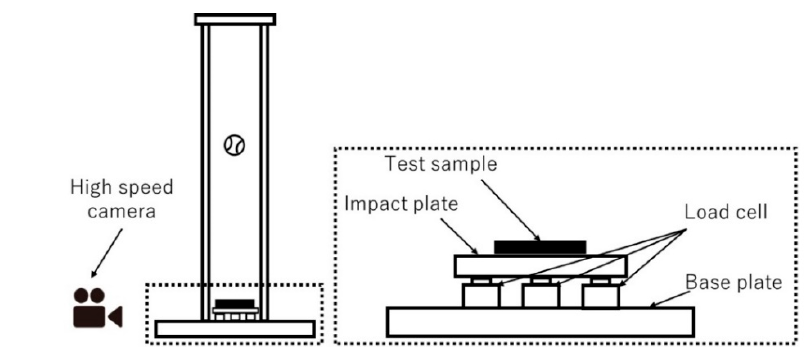
Figure 4. Drop weight impact test machine [10] .